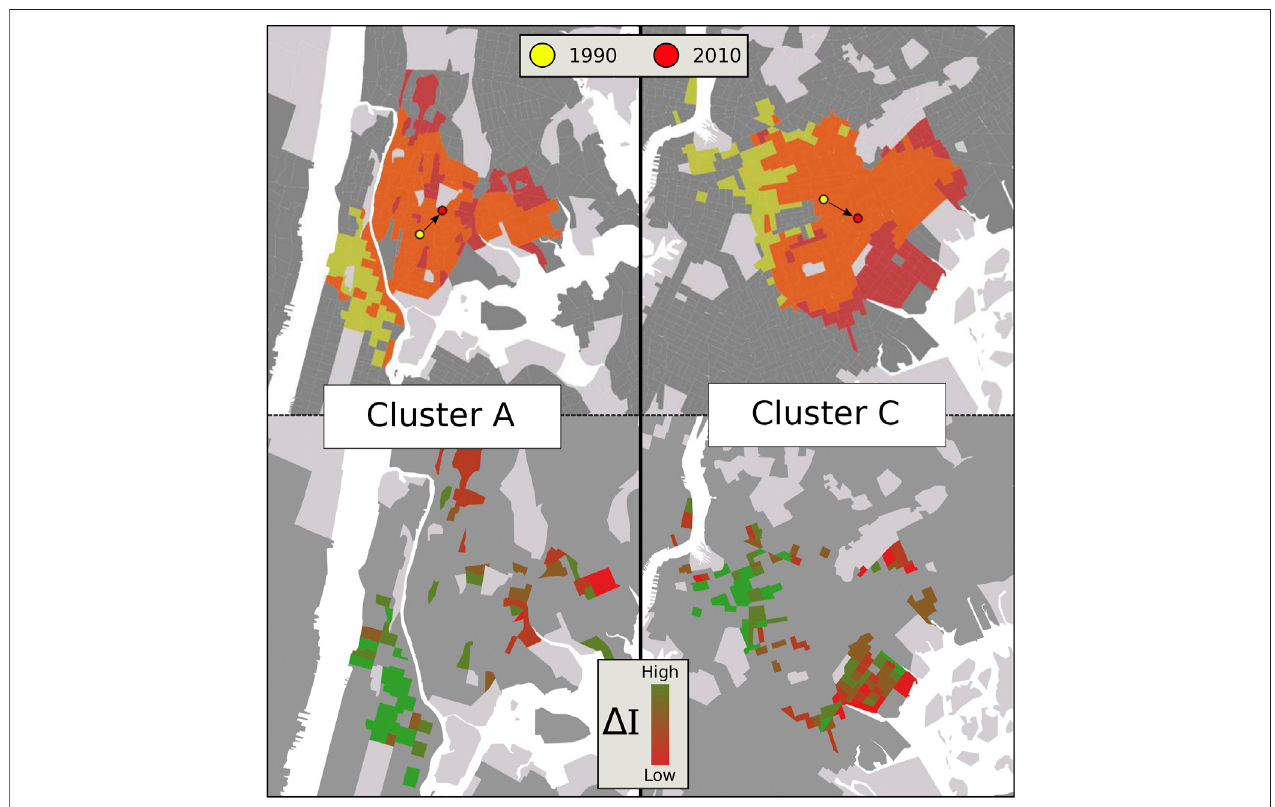
FIGURE11| DisplacementofclustersAandCandthevariationofpercapitaincome.DisplacementofclusterA,equivalenttotheneighborhood ofHarlemandthe borough of Bronx, and C, representing the borough of Brooklyn). The yellow areas represent the clusters for 1990, while red areas represent the clusters for 2010, with their respective centroids. The panels at the bottom show qualitatively the variation of the per capita income for the tracts that change zone in the period.